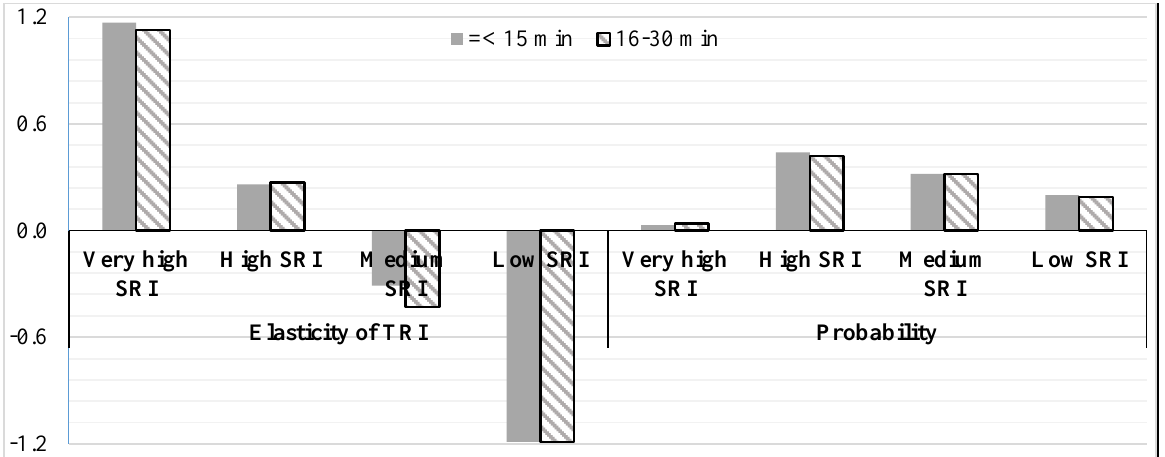
Figure 5. Elasticity and forecasting for short trips (16-30 minutes trips) towards discretionary destinations: Low (0-25%), medium (26-50%), high (51-75%) and very high (75-100%)